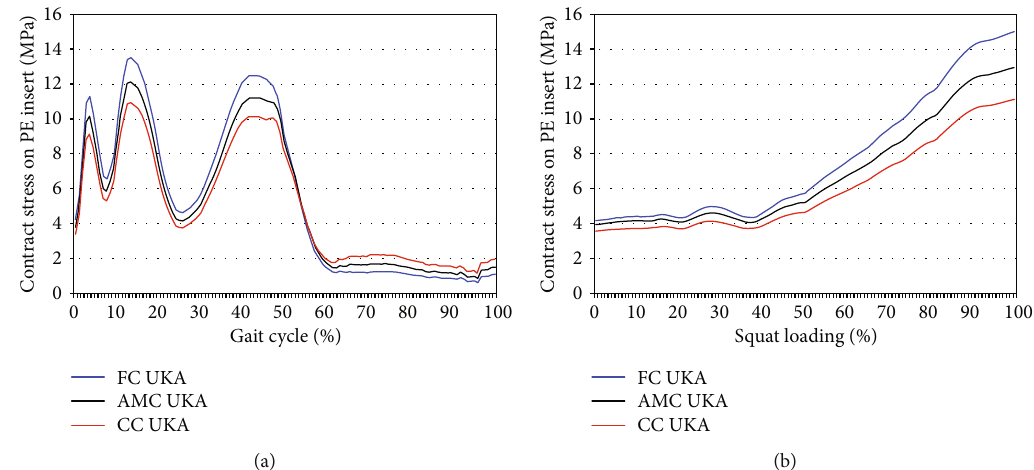
Figure 4: Comparison of the contact stress on the PE insert of three customized UKA designs with three di ff erent conformities under (a) gait and (b) squat loading